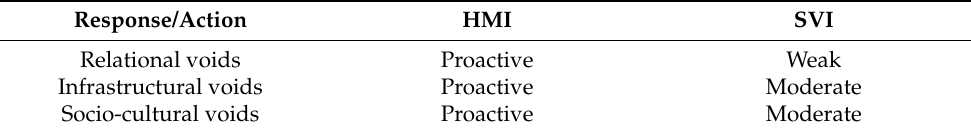
Table 1. Each firms’ efforts in responding to all three categories of institutional